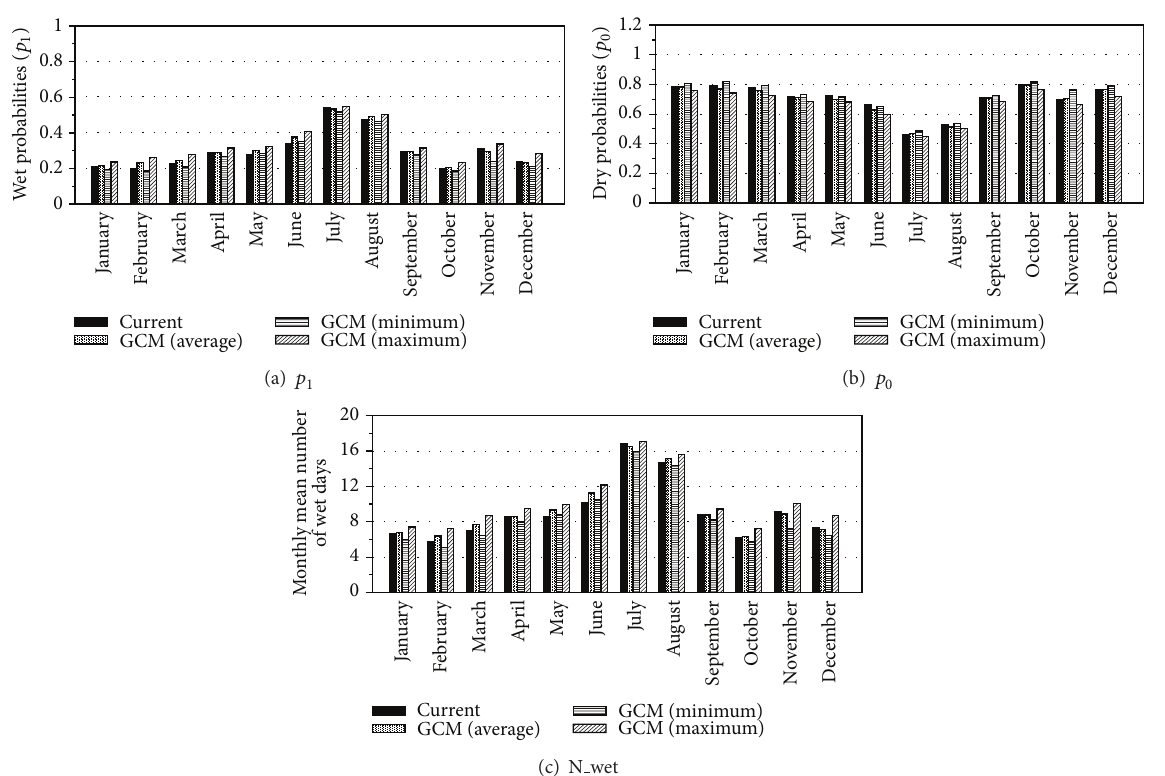
Figure 6: Wet probabilities ( 𝑝 1 ), dry probabilities ( 𝑝 0 ), and monthly mean numbers of wet days (N wet) of current (1x CO 2 ) and 2x CO 2 (GCM average, minimum, and maximum)